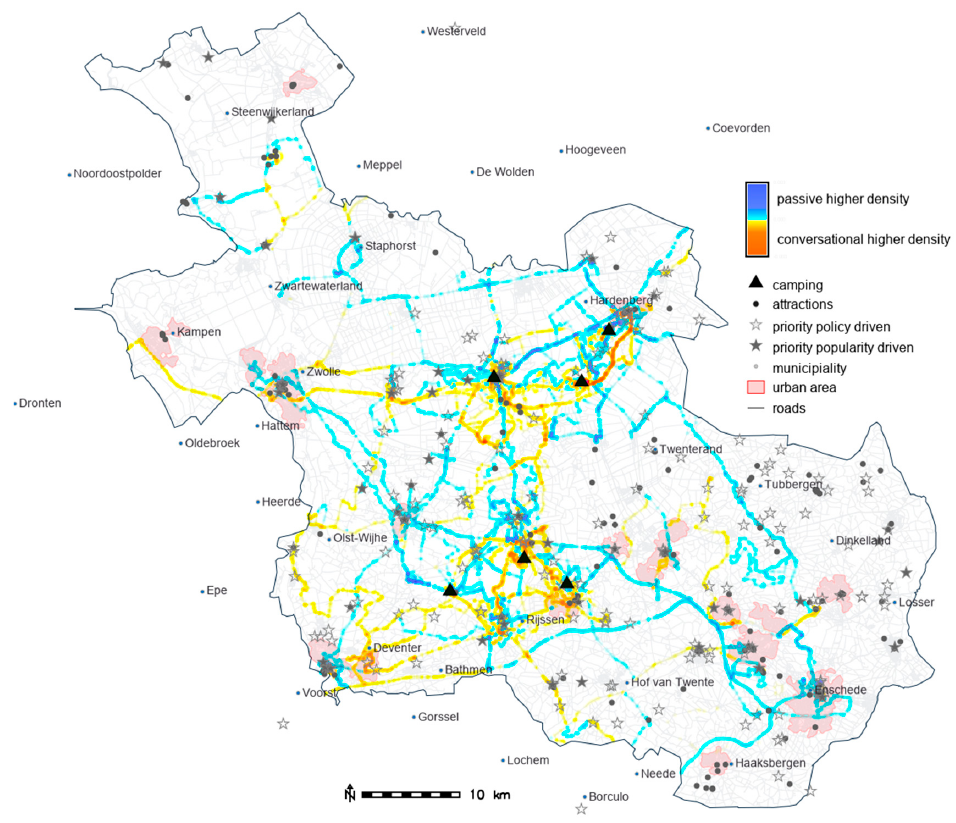
Figure 8. Difference between passive and conversational popularity-driven participants. Policy-driven participants, on the other hand, showed almost the opposite pattern. They were present south of Hardenberg and around Tubbergen if using the passive app, comprising just 21% of the movement locations on this map, but more present around Raalte, Rijssen-Holten, and Ommen if using the conversational recommender, an over- whelming 79% of movement locations (Figure 9).